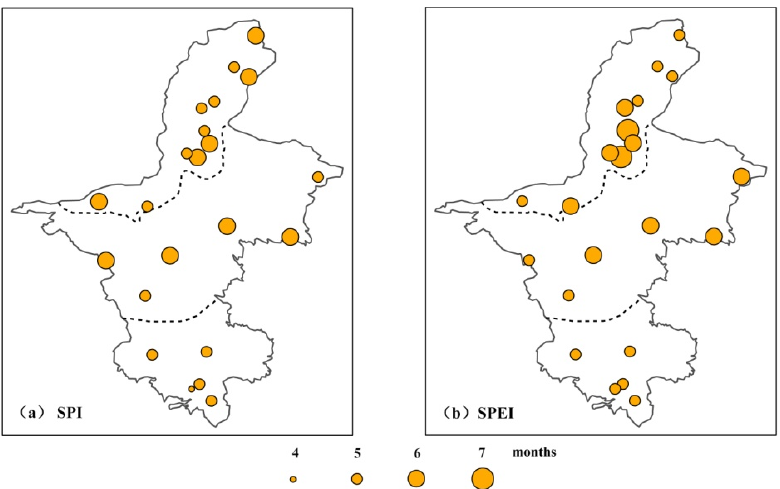
Figure 5. Average duration of drought events identified from monthly SPI/SPEI values at the 3-month time scale for 22 stations during the years 1972–2011 in Ningxia. ( a ) SPI, ( b ) SPEI.